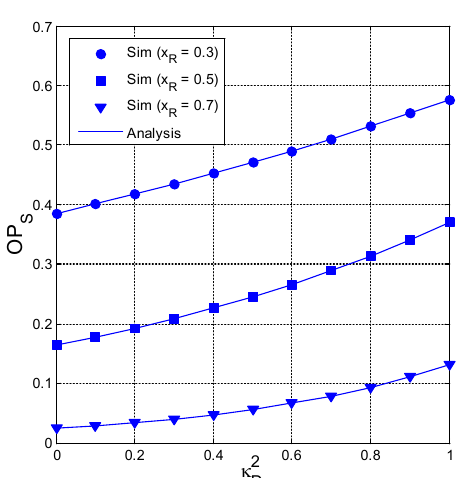
OP as a function of S